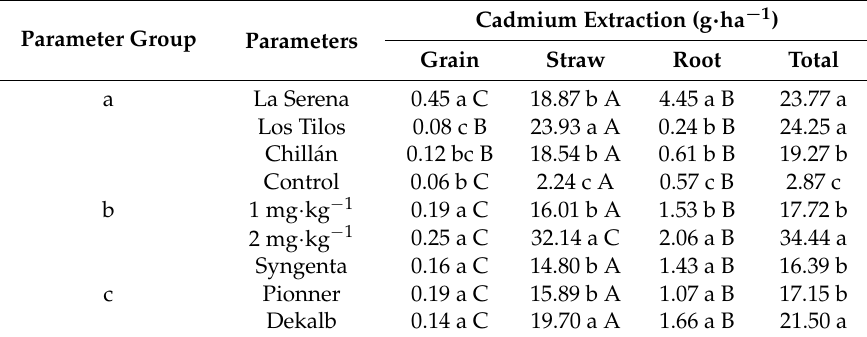
Table 5. Cadmium extraction levels (g · ha − 1 ) for each maize plant organ for: (a) different environments; (b) CdCl 2 rates; and (c) maize